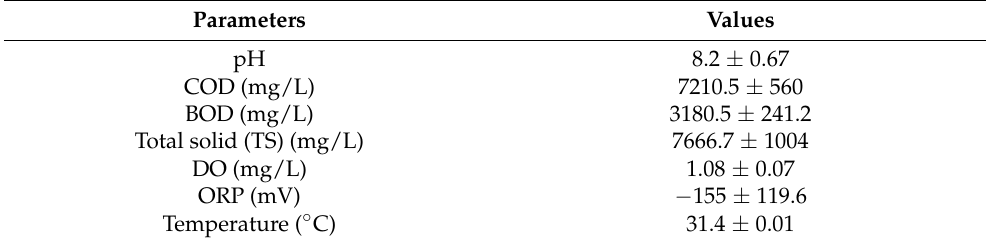
Table 1. The characteristics of the POME solution used in this study. Data shown in the tables are mean values from triplicate experimental with standard